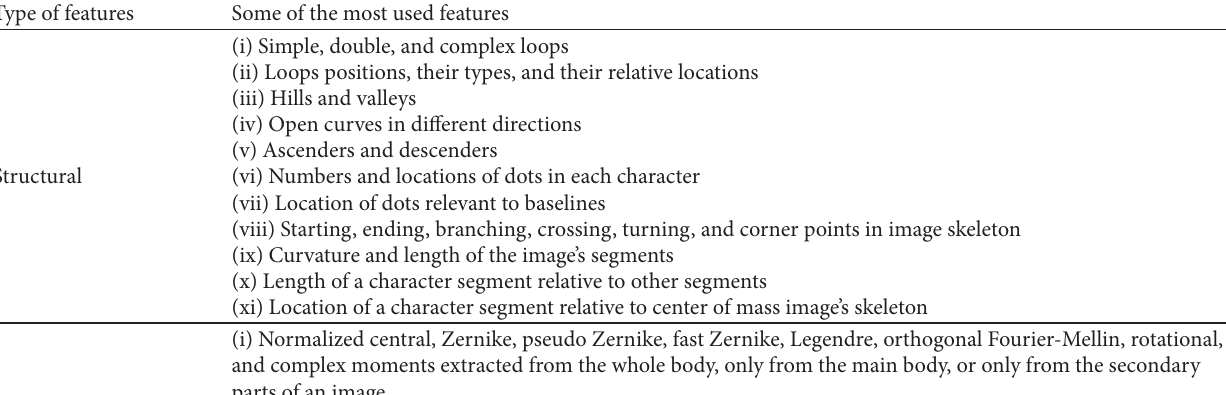
Table 1: Some of the most used features in OCR